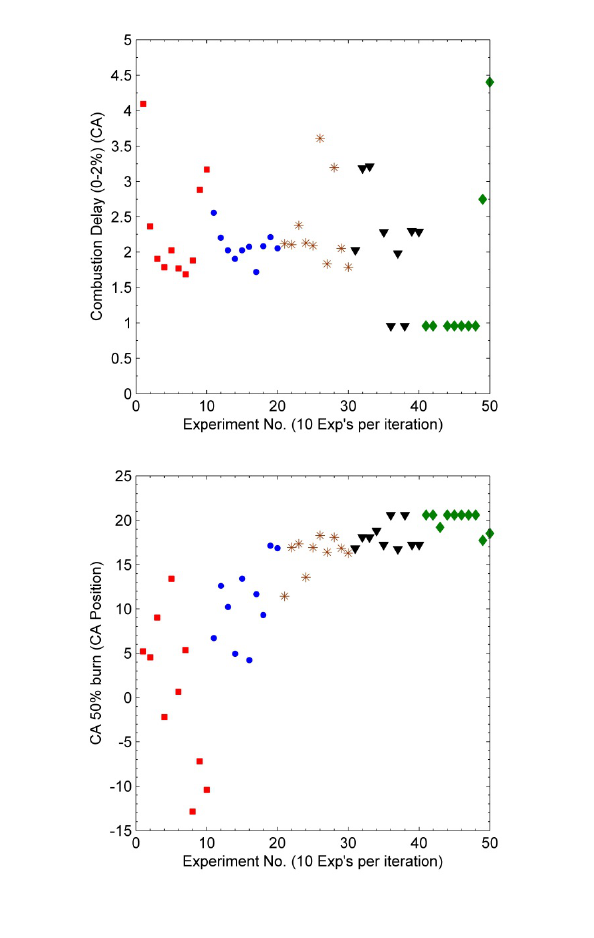
mization. Mostly low swirl numbers are suggested by the optimization indicating that adequate mixing is present even at low swirl numbers. Tumble results showed that this design variable did not influence the merit function in either direction. A clear trend was not observed in the tumble values throughout the runs.